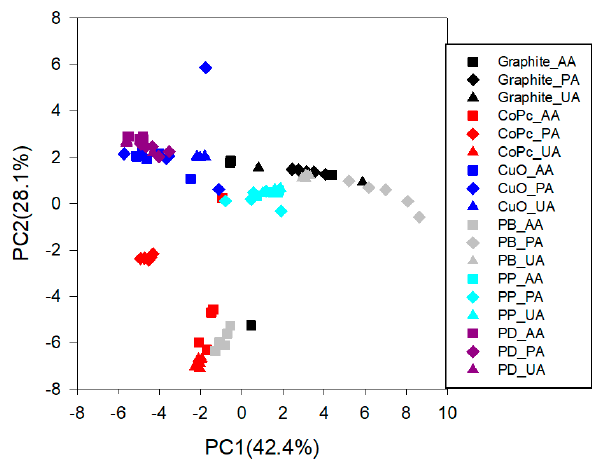
Figure 6. Score plot of the two components obtained after Principal Component Analysis (PCA) analysis. Five replicates for each sensor were done determining the three compounds of interest: Acetaminophen, Ascorbic acid and Uric acid.